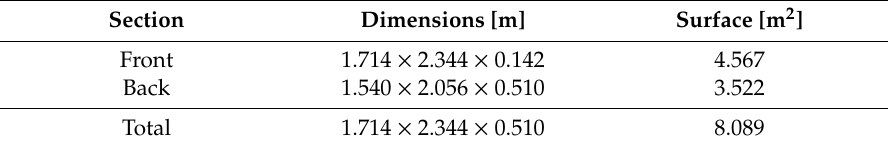
Table 11. Overall geometrical dimensions for roof sections.